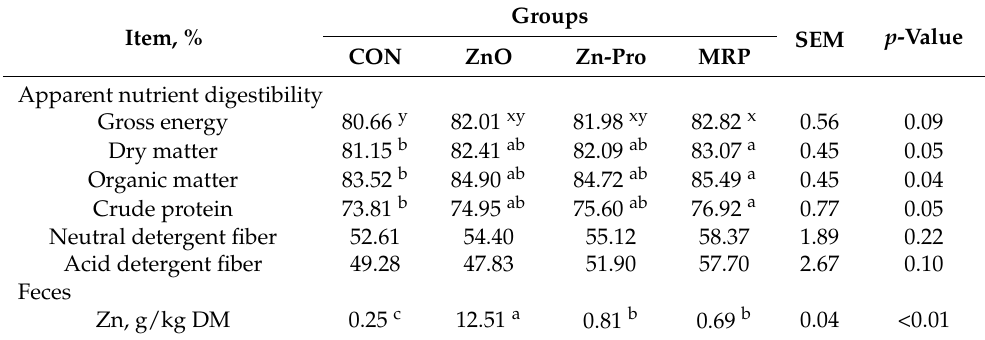
Table 3. Effects of different treatments on nutrient apparent digestibility and fecal zinc excretion in the different groups.